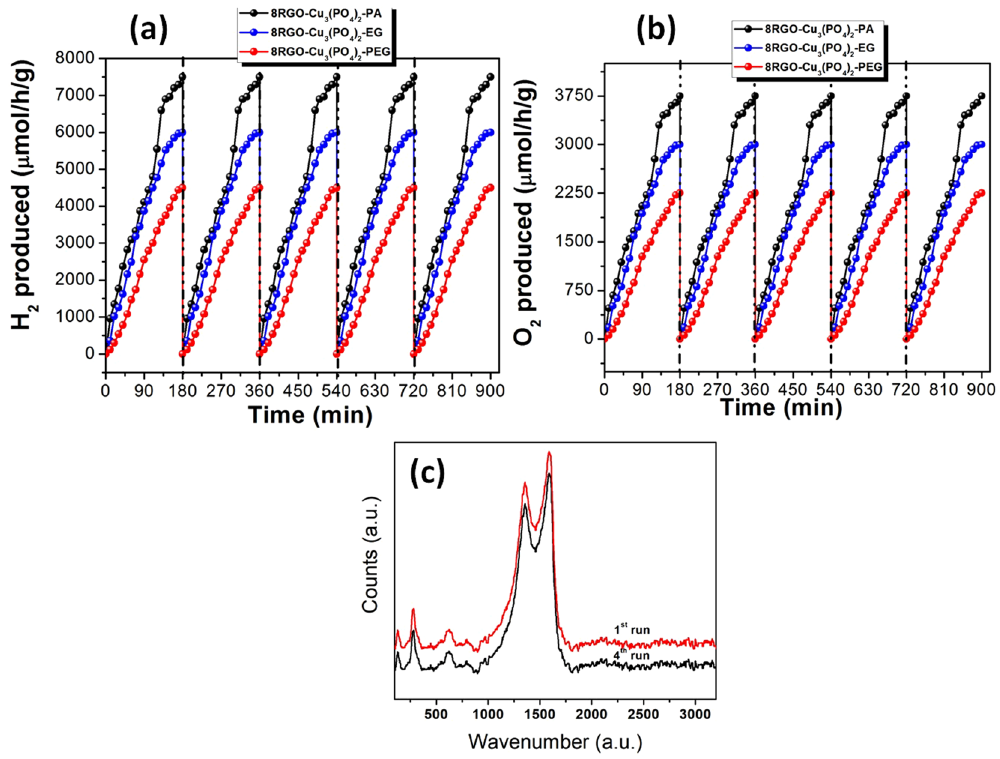
Figure 13. Reusability tests for the 8RGO-Cu 3 (PO 4 ) 2 -PA/EG/PEG heterojunction photocatalysts to produce ( a ) H 2 and ( b ) O 2 via water splitting. Over every 180 mins the reaction system is bubbled with N 2 for 15 min to remove the H 2 /O 2 inside the reactor. ( c ) Comparison of raman spectra of pristine and used 8RGO- Cu 3 (PO 4 ) 2 -PA after 4 th run (900 mins) during H 2 production.